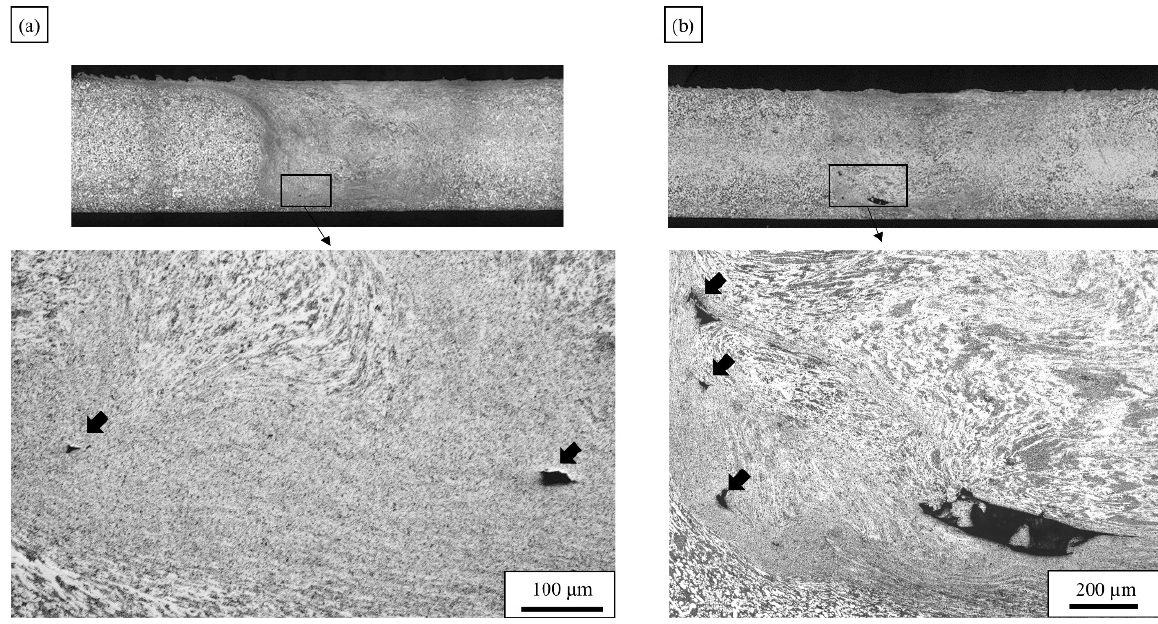
Figure 10. Evolution of defects in AlSi10MnMg welds as a function of welding speed ( a ) 1000 mm/min; and ( b ) 1500 mm/min. Arrows marks indicate the presence of small cavities in the weld .